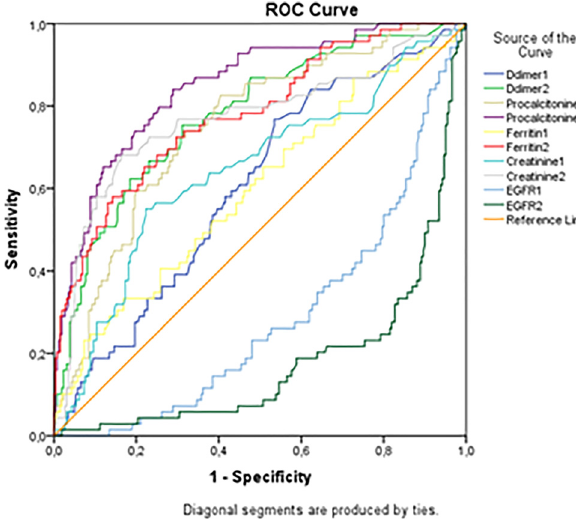
Figure 1: ROC curves of creatinine, e-GFR, ferritin, D-dimer and